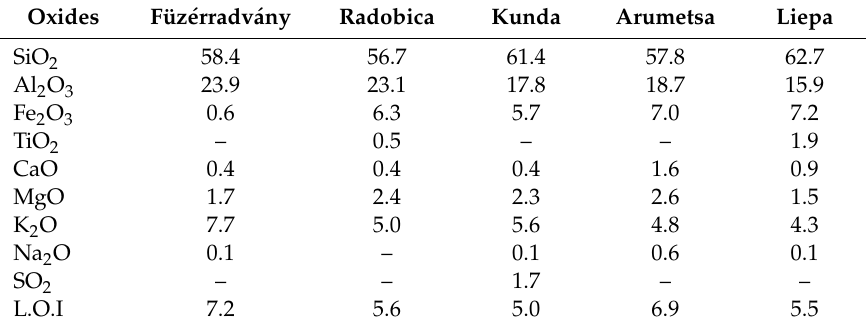
Table 2. Chemical composition of the investigated clays (in mass%)